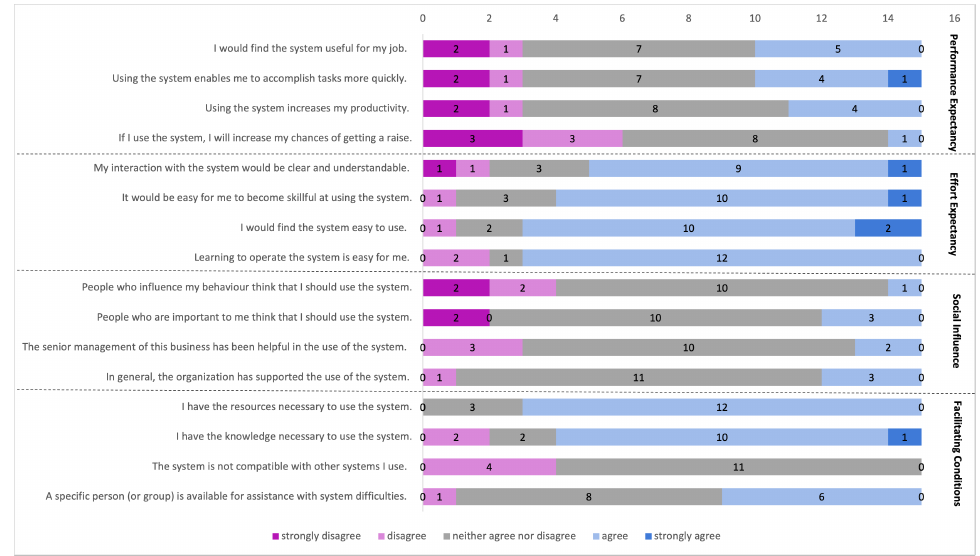
Figure 18. The UTAUT questionnaire results for the analysis of plant growth use case. Each coloured section indicates the number of participants who responded between ‘strongly disagree’ and ‘strongly agree’ (i.e., frequency).